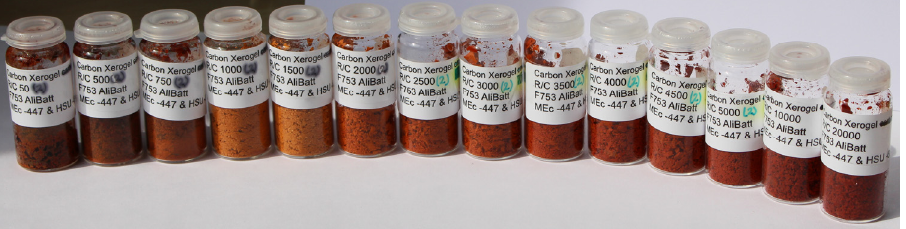
Figure 1. As-prepared resorcinol-formaldehyde resins after drying step from high catalyst concen- tration (R/C = 50) on the left side to low concentration (R/C = 20,000) on the right